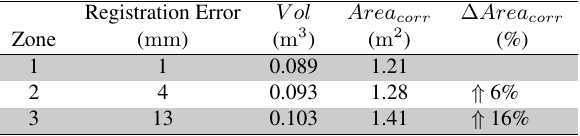
Table 1. Detection results using different standard evaluation metrics.